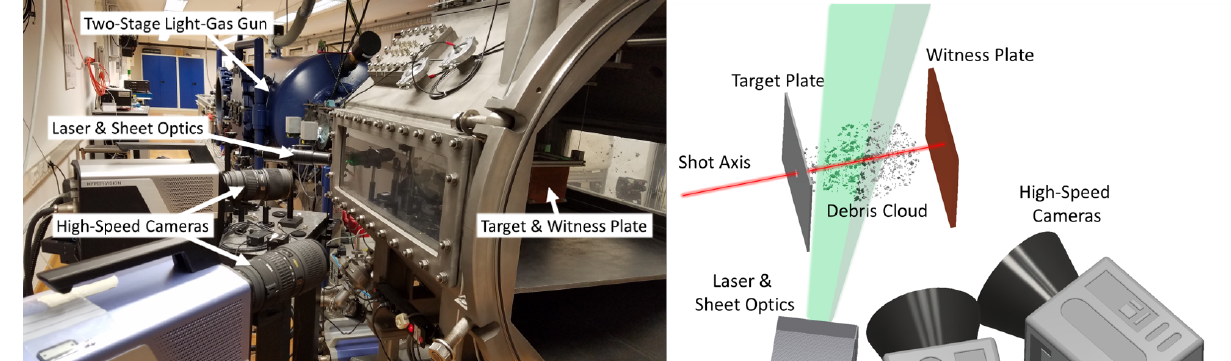
Figure 2. Setup for hypervelocity impact experiment to measure 3D spatially and temporally resolved fragmentation data. The experiment involves using two synchronized high-speed cameras to record the flight of debris fragments following a HVI event. The fragments are illuminated as they pass through the laser